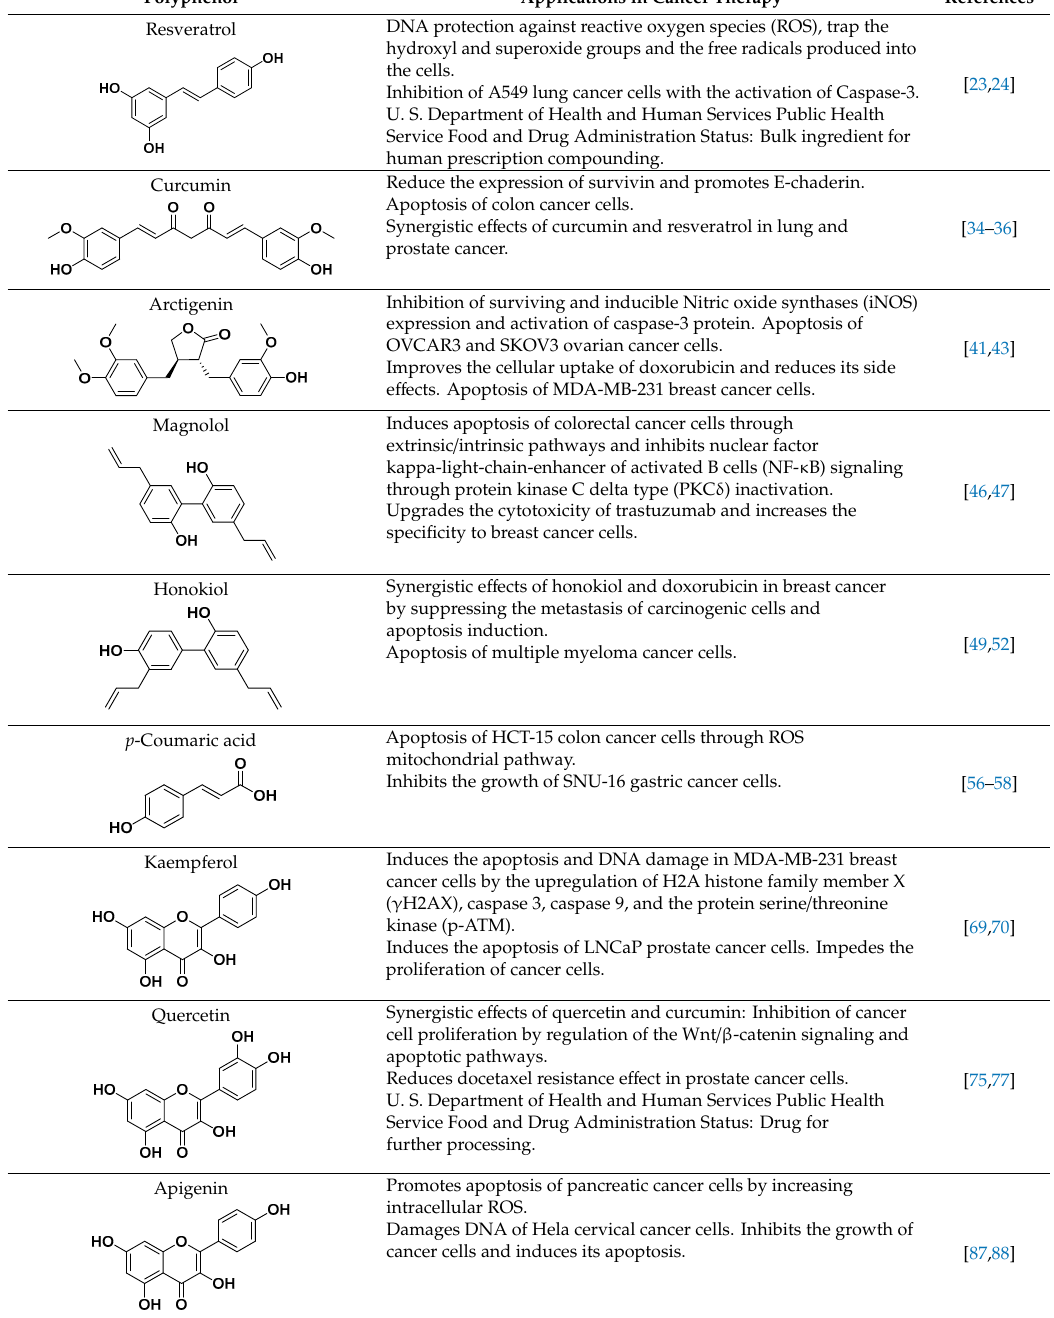
Table 1. Summary of various polyphenols, their chemical structures, and their anticancer effects. Polyphenol Resveratrol